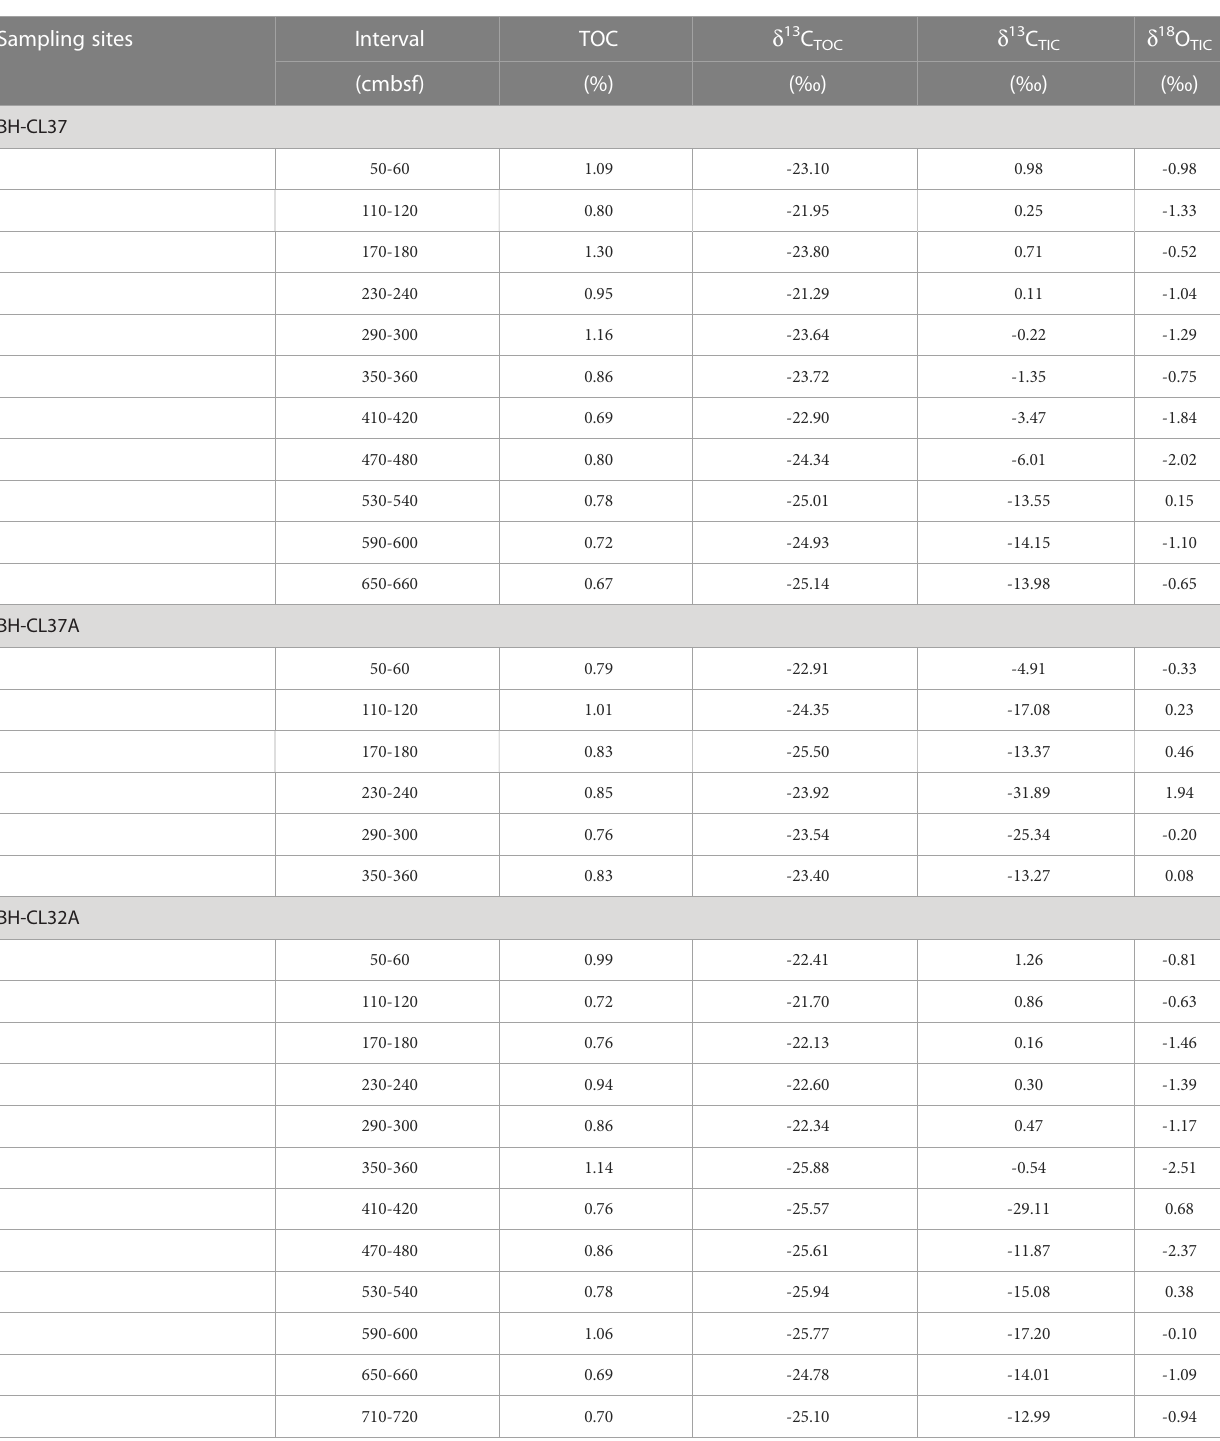
TABLE 6 Data of TOC, d 13 C TOC , d 13 C TIC and d 18 O TIC in sediments. Sampling